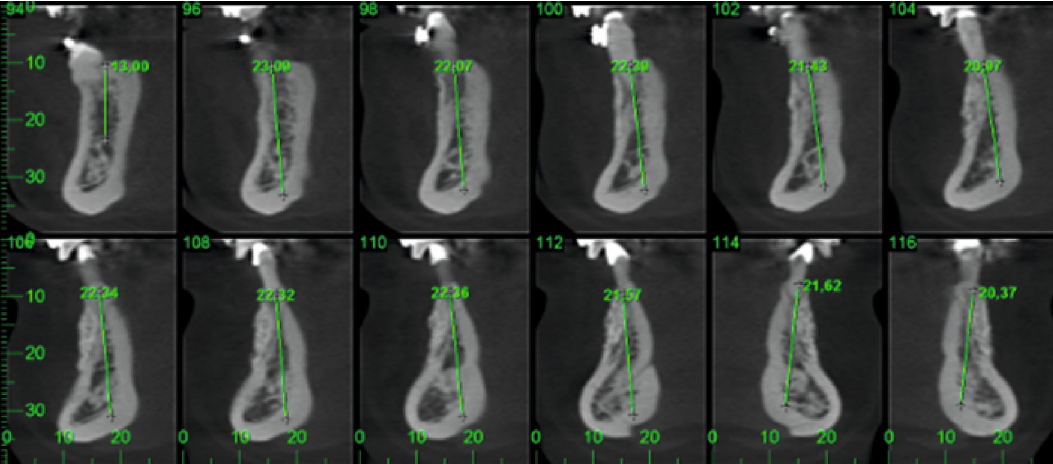
Figure 4: Postoperatory tomography radiograph 12 months after the horizontal bone augmentation, showing new bone formation, allowing the correct three-dimensional placement of dental implants.